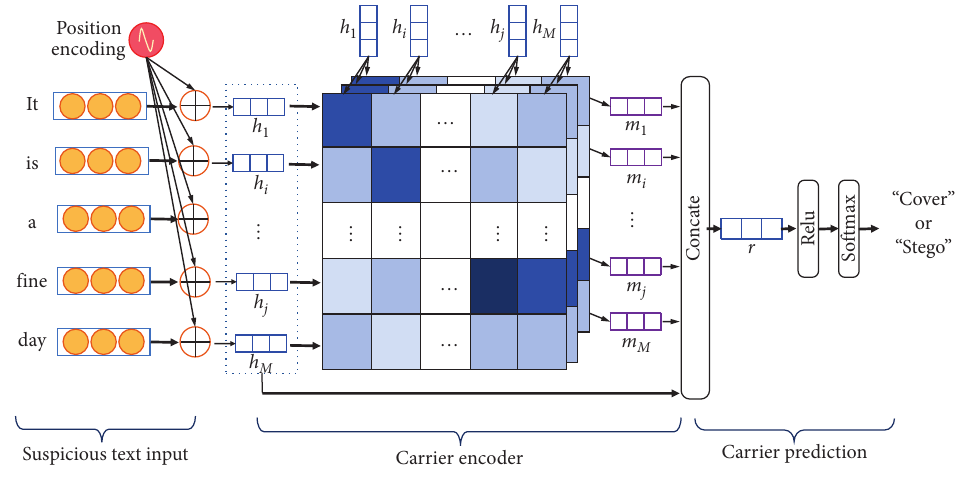
Figure 1: Structure of proposed linguistic steganalysis